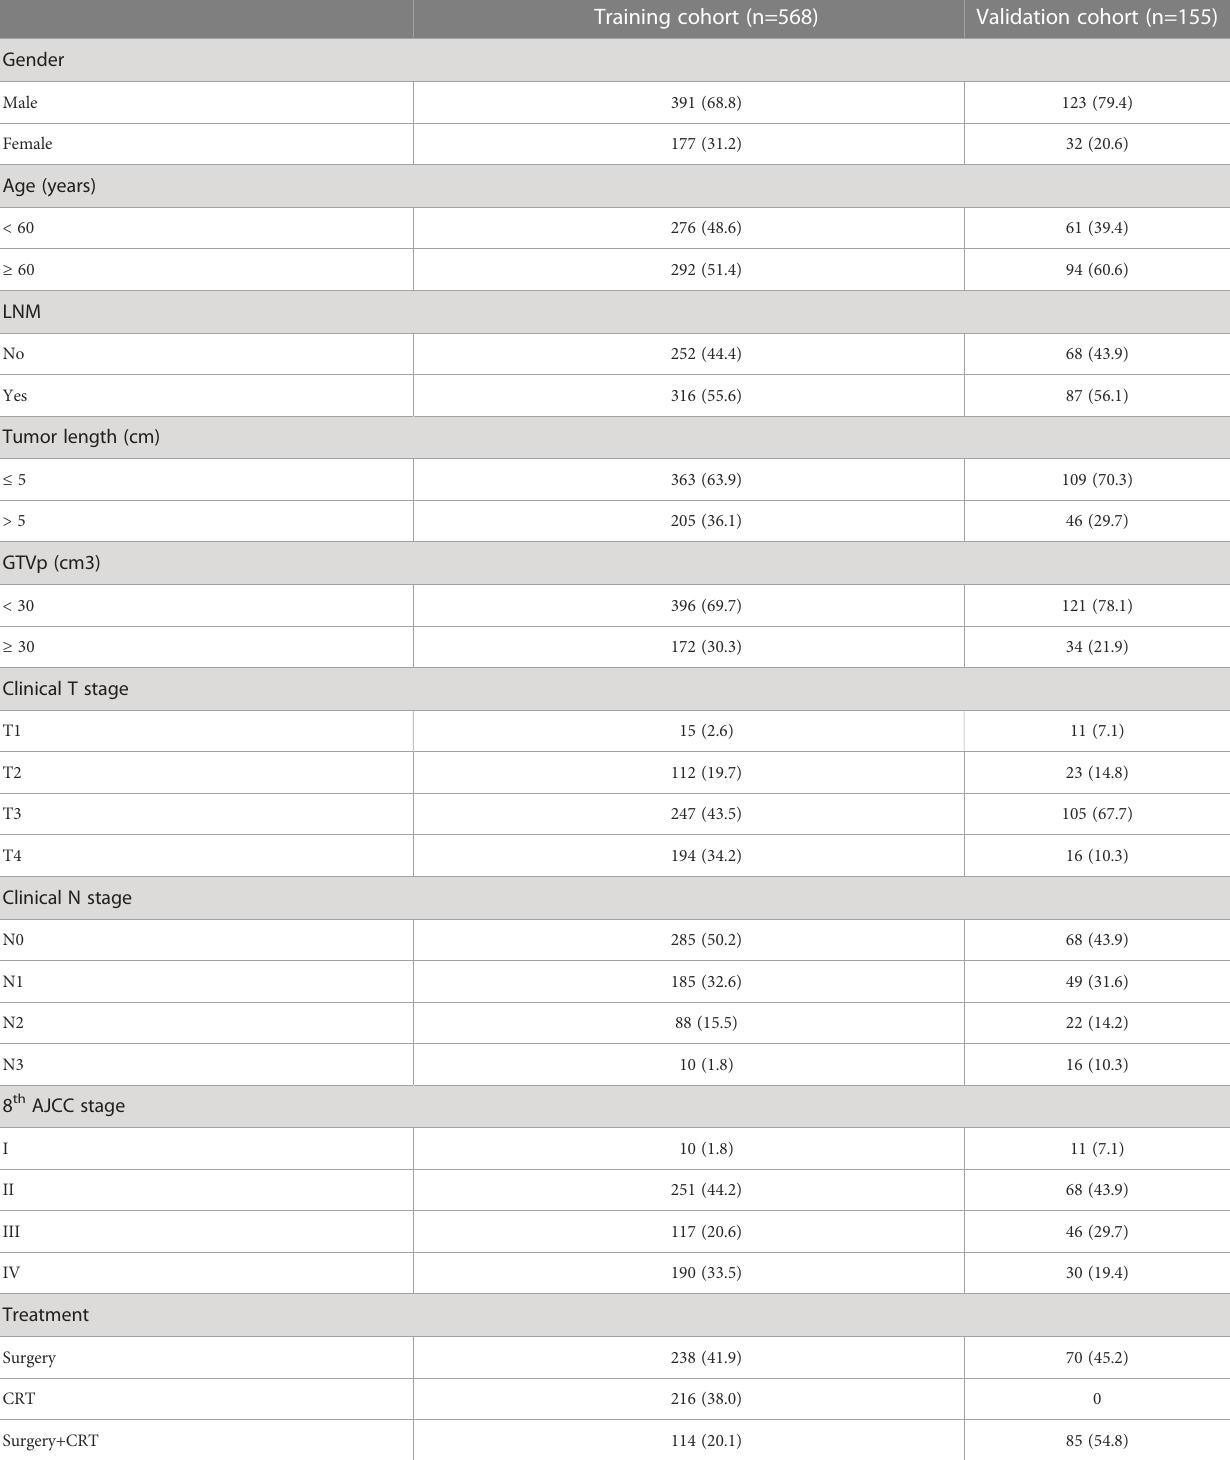
TABLE 1 Clinical characteristics of patients with upper thoracic esophageal squamous carcinoma in two